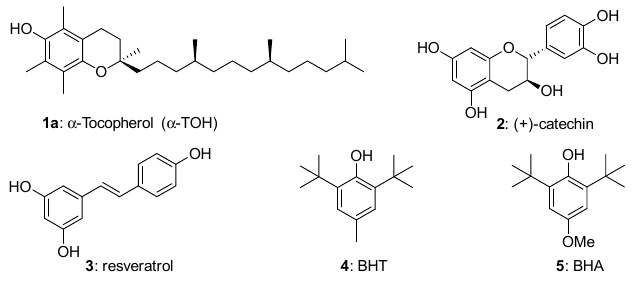
Figure 1. Structure of model natural and synthetic phenolic antioxidants. BHT—butylated hydroxytoluene; HBA—butylated hydroxyanisole.